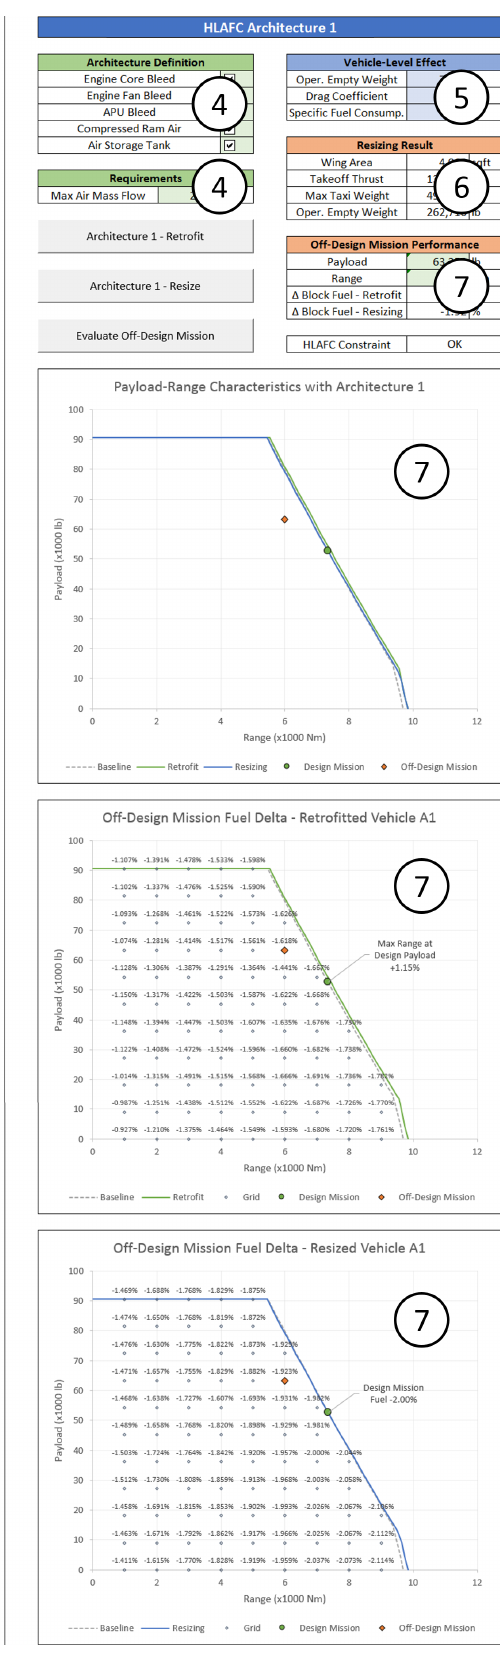
Figure 3. Main user interface of RATE (enumerated notes correspond to the annotated numbers